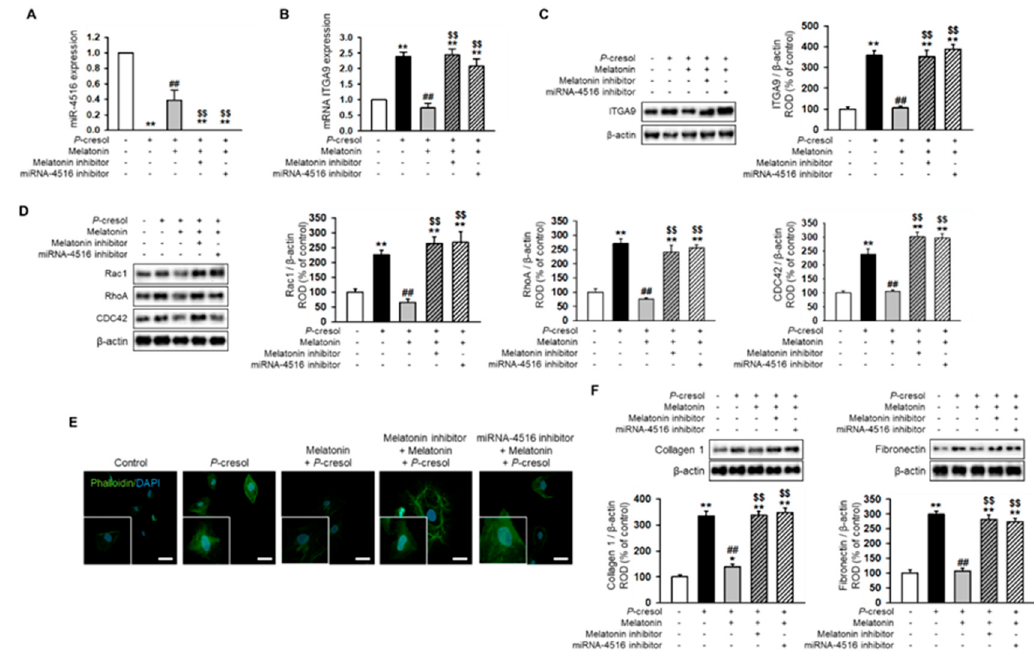
Figure 3. Melatonin reduces cytoskeleton reorganization and expression of fibrosis markers via increased expression of miR-4516. ( A , B ) Expression of miR-4516 and ITGA9 was detected in melatonin-treated TH1 cells (1 μ M for 24 h) under P -cresol exposure (0.5 mM for 72 h). TH1 cells were pre-treated with the miR-4516 inhibitor (200 nM) or luzindole (melatonin inhibitor, 1 μ M) for 48 h and then treated with melatonin ( n = 3). The values represent mean ± SEM. ** p < 0.01 vs. control, ## p < 0.01 vs. P -cresol exposure condition, $$ p < 0.01 vs. melatonin-treated TH1 cells in P -cresol exposure condition. ( C , D ) Western blot analysis for ITGA9, Rac1, RhoA, and CDC42 in melatonin-treated TH1 cells (1 µ M for 24 h) or pre-treated with the miR-4516 inhibitor (200 nM for 48 h) or luzindole (1 µ M for 48 h) under P -cresol exposure (0.5 mM for 72 h) ( n = 3). Protein levels were determined by densitometry relative to that of β -actin. The values represent mean ± SEM. ** p < 0.01 vs. control, ## p < 0.01 vs. P -cresol exposure condition, $$ p < 0.01 vs. melatonin-treated TH1 cells in P -cresol exposure condition. ( E ) Phalloidin staining was performed in melatonin-treated TH1 cells (1 µ M for 24 h) or pre-treated with the miR-4516 inhibitor (200 nM for 48 h) or luzindole (1 µ M for 48 h) in exposure to P -cresol (0.5 mM for 72 h) (scale bar = 40 µ m, n = 3). ( F ) Western blot analysis for collagen type 1 and fibronectin in melatonin-treated TH1 cells (1 µ M for 24 h) or pre-treated with the miR-4516 inhibitor (200 nM for 48 h) or luzindole (1 µ M for 48 h) under P -cresol exposure (0.5 mM for 72 h) ( n = 3). Protein levels were determined by densitometry relative to that of β -actin. The values represent mean ± SEM. ** p < 0.01 vs. control, ## p < 0.01 vs. P -cresol exposure condition, $$ p < 0.01 vs. melatonin-treated TH1 cells in P -cresol exposure